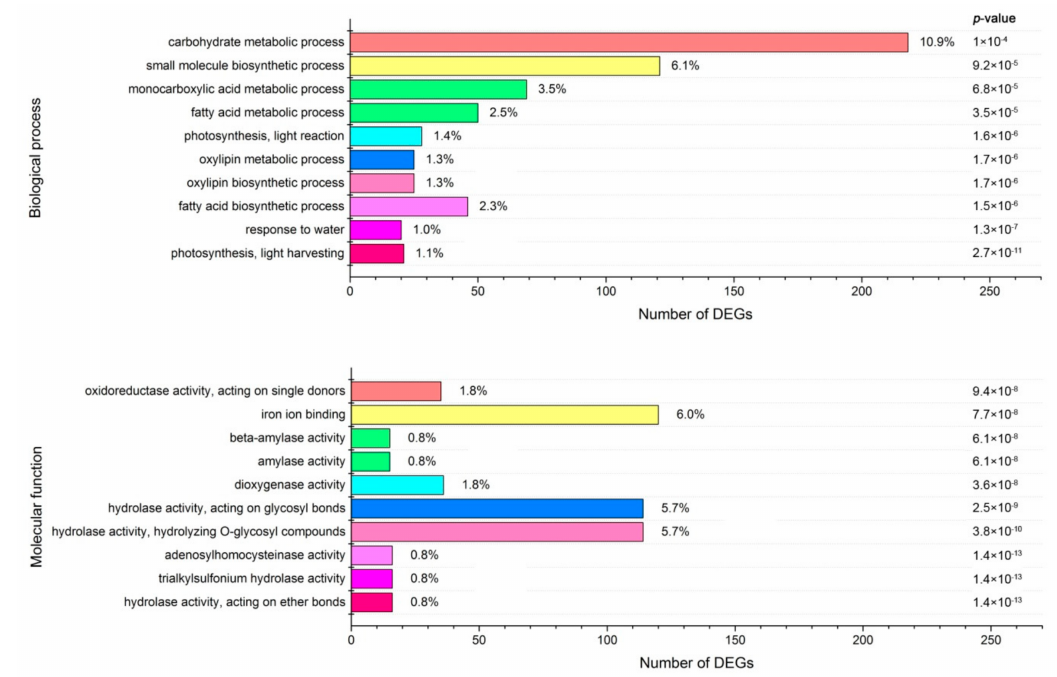
Figure 6. Gene ontology (GO) enrichment analysis of DEGs. The genes were assigned to two main categories: Biological process and molecular function. The names of the GO categories are listed along the y-axis. The number on the right of the column indicates the proportion of the gene number corresponding to each category in the total number of DEGs. The degree of GO enrichment is represented by the false discovery rate (FDR) value and the number of unigenes enriched in each category. The FDR value indicates the corrected p-value, ranging from 0 to 1, and an FDR value closer to 0 indicates a greater